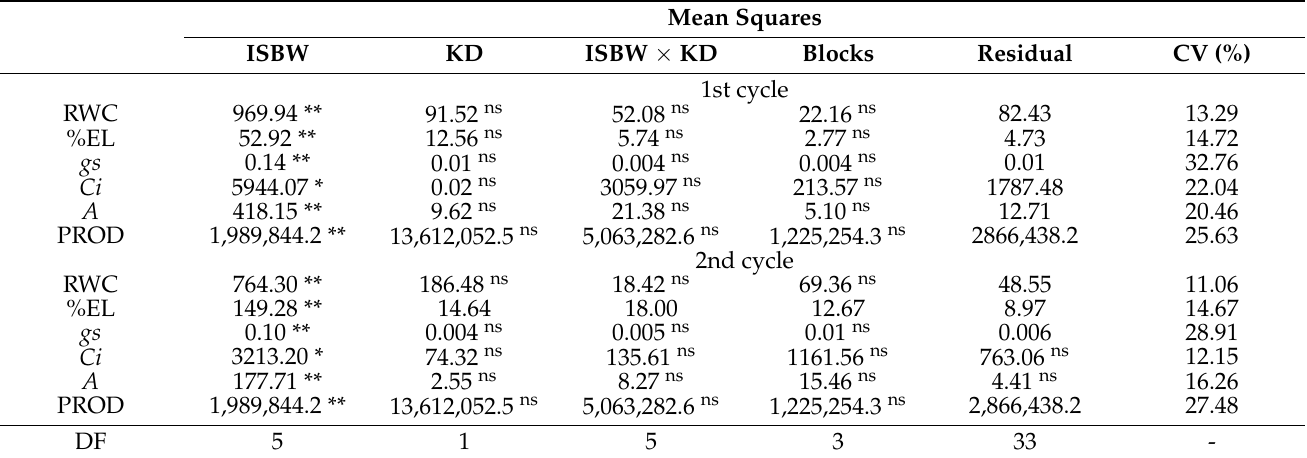
Table 2. Analysis of variance for relative water content (RWC), electrolyte leakage (%EL), stomatal conductance ( gs ), intercellular concentration of carbon dioxide ( Ci ), photosynthesis ( A ), and pro- duction per plant (PROD) in Passiflora edulis Sims under brackish water irrigation strategies (ISBW) (ISBW) and potassium fertilization